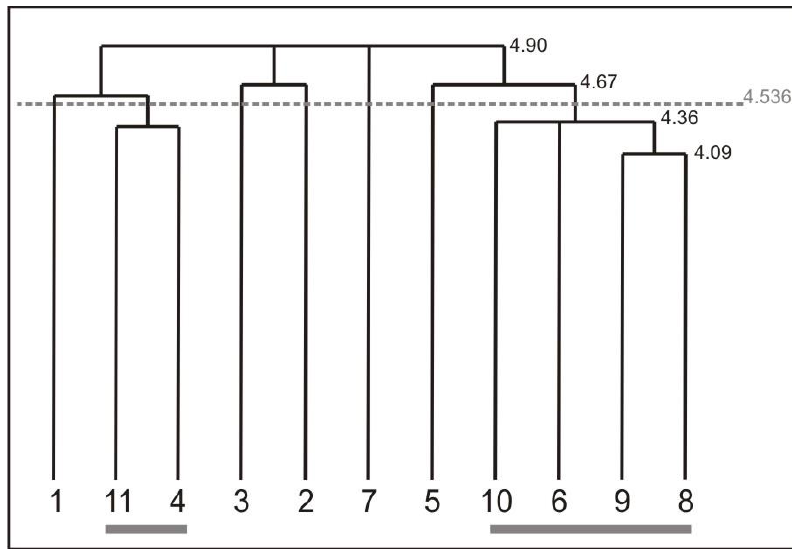
Figure 6. Mean results of the cognitive representation of the screwing action of all workers measured at the retention test. For interpretation of the dendrogram, see Figure 5 in Section 3.1.3. The used BACs are labelled in Table 4.